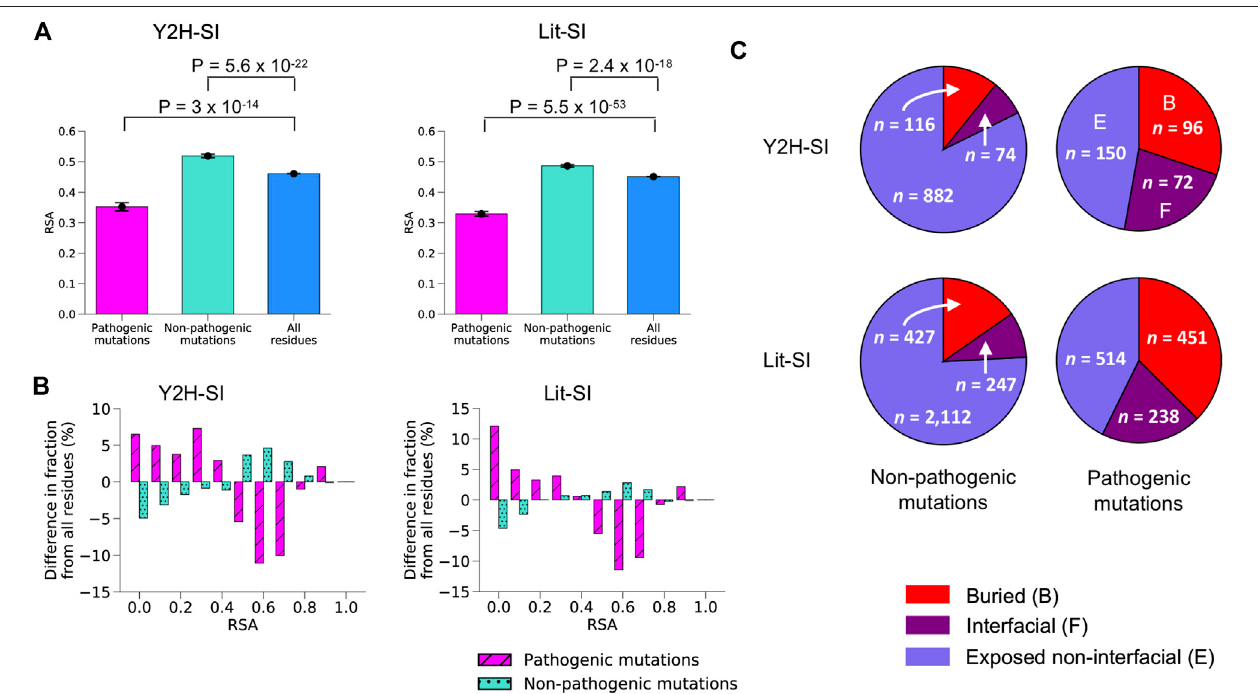
FIGURE 2 | Mutation locations on protein structural models. (A) Average RSA for pathogenic mutations, non-pathogenic mutations and all residues in the two humanstructuralinteractomesY2H-SI (left) andLit-SI (right) .Errorbarsrepresentstandarderrorsofthemean.Statisticalsigni fi cancewascalculatedusingatwo-sided t -test. (B) Difference in RSA distribution for pathogenic mutations and non-pathogenic mutations compared to all residues in the two human structural interactomes Y2H-SI (left) and Lit-SI (right) . (C) Fraction of buried mutations, interfacial mutations, and exposed non-interfacial mutations among common non-pathogenic mutations (left) and among pathogenic mutations (right) in the two human structural interactomes Y2H-SI (top) and Lit-SI (bottom) . Red slices represent buried mutations, purple slices represent interfacial mutations, and blue slices represent exposed non-interfacial